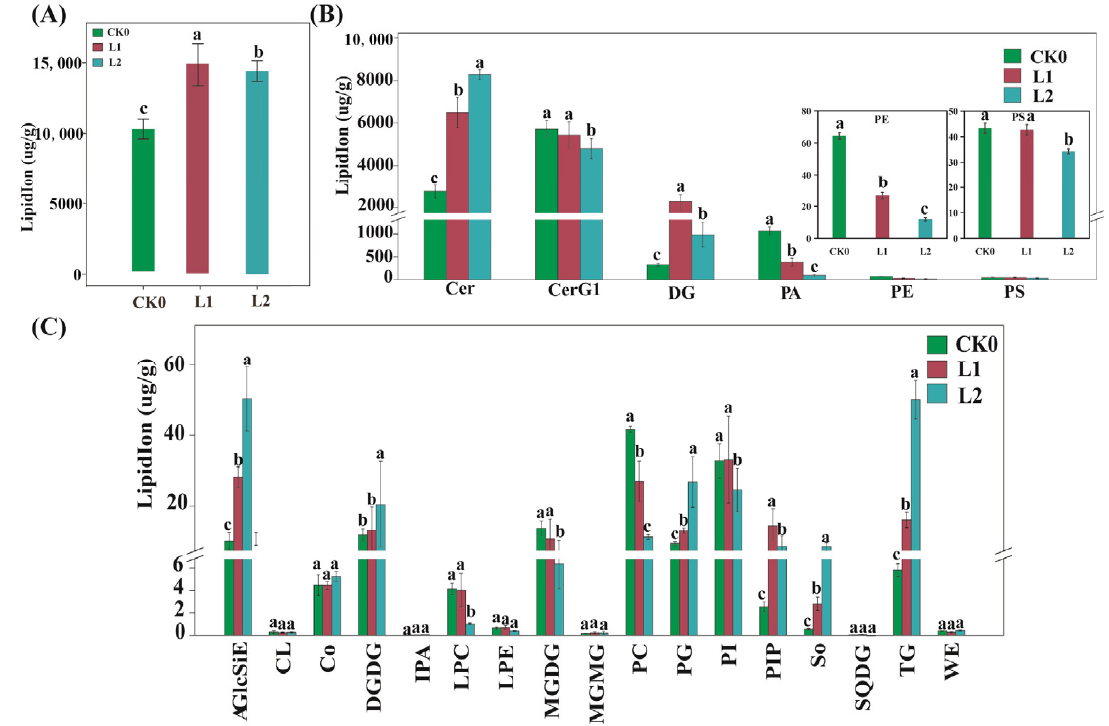
Figure 5. ( A ) Total lipid content of SH peach fruit at the indicated time points during cold storage. ( B , C ) Lipid class content of SH peach fruit at the indicated time points during cold storage. LipidIon represents total lipid content. AGlcSiE, AcylGlcSitosterol ester; Cer, ceramide; CerGl, monoglycosylceramide; Co, coenzyme; DG, diacyglyceride; DGDG, digalactosyldiacylglycerol; DGMG, digalactosylmonoacyglycerol; FA, fatty acid; LPC, lysophosphatidylcholine; LPE, lysophosphatidylethanolamine; LPG, lysophosphatidylglycerol; MGDG, monogalactosyldiacylglycerol; MGMG, monogalactosylmonoacylglycerol; PA, phosphatidic acid; PC, phosphatidylcholine; PE, phosphatidylethanolamine; PG, phosphatidylglycerol; PI, phosphatidylinositol; PIP, phosphatidylinositol; PS, phosphatidylserine; So, sphingosine; SQDG, sulfoquinovosyldiacyglycerol; and TG, triacyglyceride. Differences between samples were analyzed by one-way ANOVA, according to Fisher’s least significant difference (LSD) test. The error bars represent the standard error (SE) calculated from three independent biological replicates; in each plot, bars with the lowercase letters (a, b, or c) are significantly different ( p < 0.05).